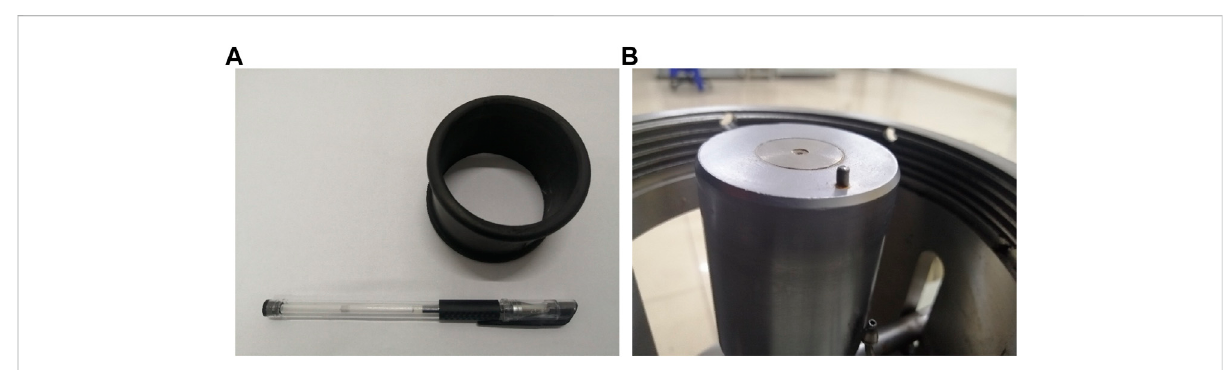
FIGURE 4 Schematic of the experimental system.